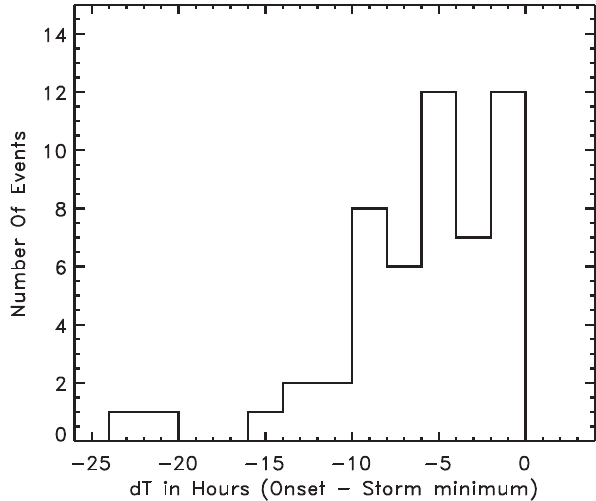
Fig. 7a. Histogram of the number of substorm onsets during main phase development relative to the time of Sym-H minimum ( 1 UT) (after Wu et al., 2004, Fig. 4).